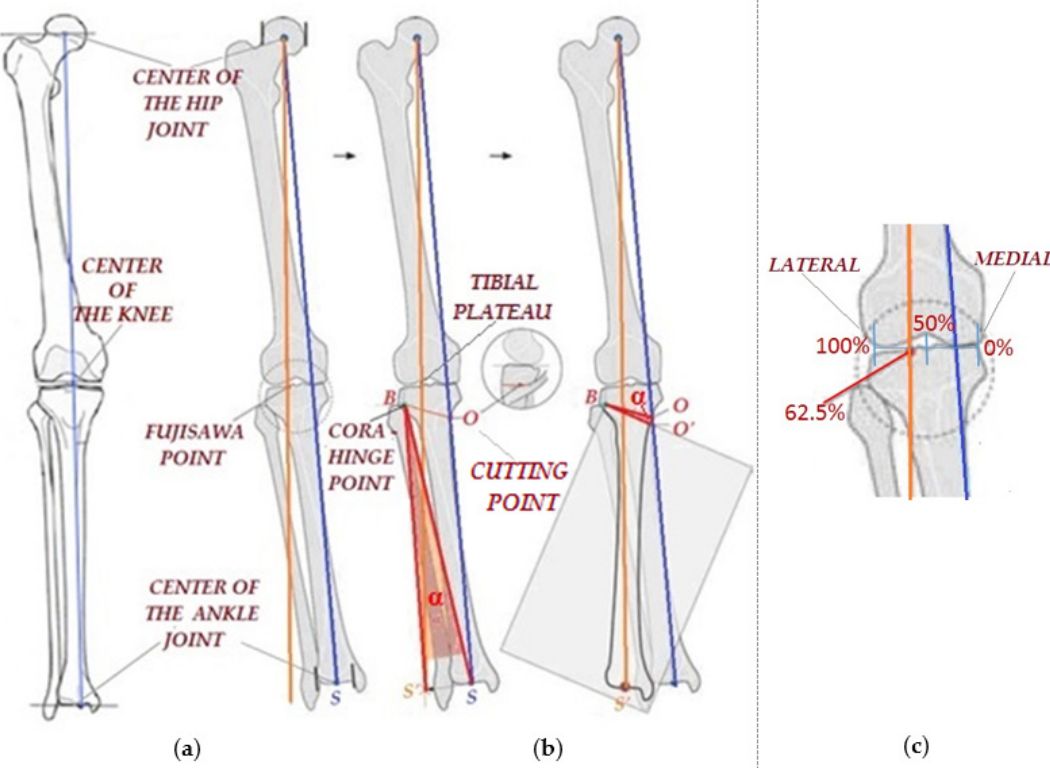
Figure 1. Medial open wedge high tibial osteotomy (HTO)—mechanical axis of the lower limb ( a ), main steps ( b ) and Fujisawa point ( c ).